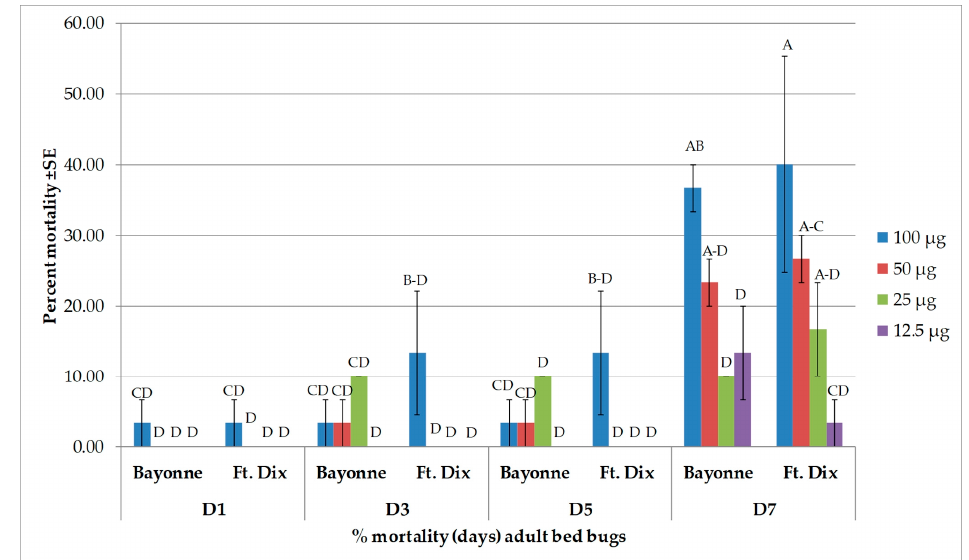
Figure 4. Mean (±SE) mortality produced by topical application of caryophyllene oxide on two strains of bed bug. Levels not connected by the same letter are significantly different. There were three replications per treatment with 10 bed bugs per replication (Three-Factor ANOVA, p < 0.05, mean separated by Tukey’s HSD Test; JMP® 10.0). Deltamethrin (2.4 ng, positive control) had killed 36.6% ± 3.33% (Bayonne) and 100% (Ft. Dix) by 24 h post treatment. The mortality rate in the Bayonne strain increased to 43.3% ± 8.82% from days 3 to 7.